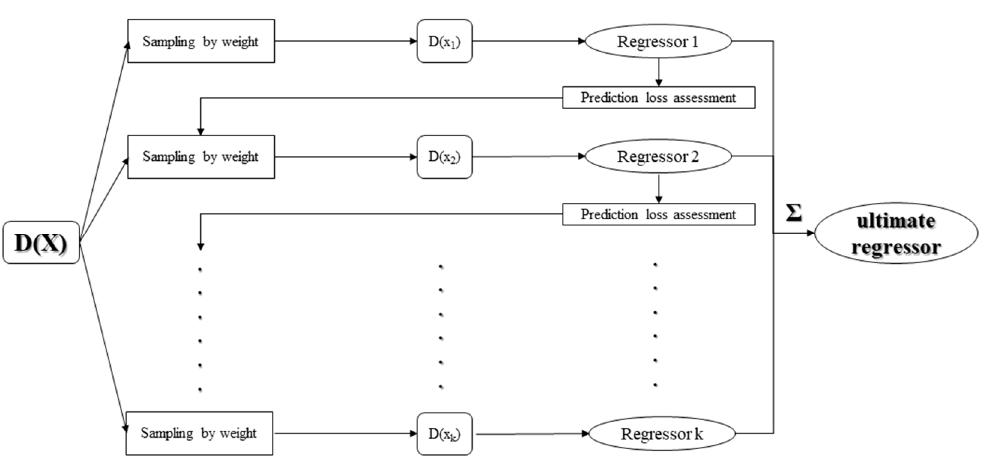
Figure 2. Schematic diagram of adaptive boosting (AdaBoost) regression.